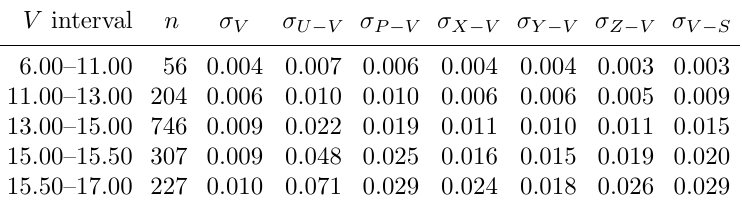
Table 2. Internal accuracy of the photometric